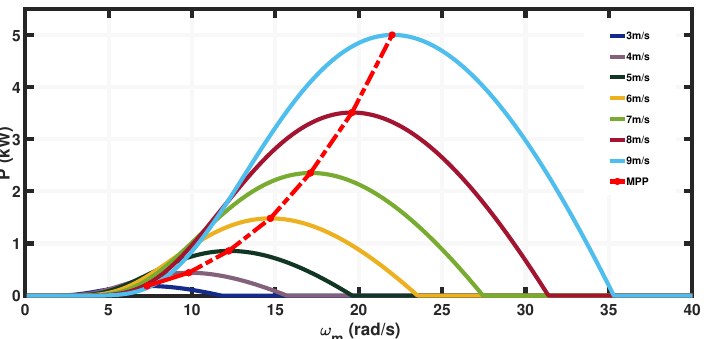
Figure 3. The wind power versus wind speed characteristics of the 5 kW PMVG-based